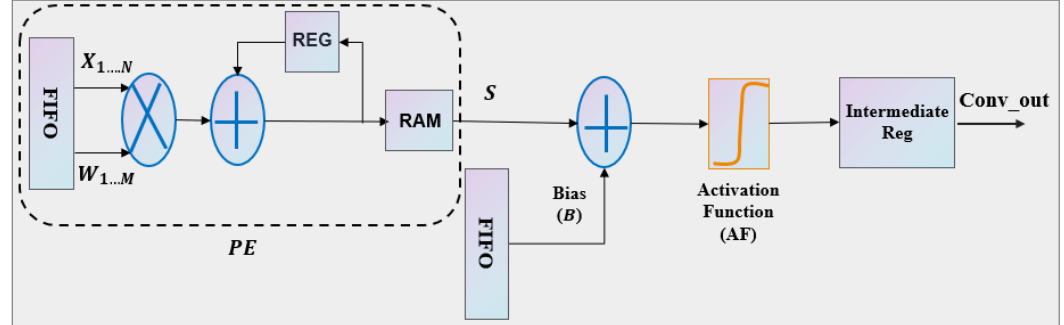
Figure 11. Hardware architecture of the convolutional layer.